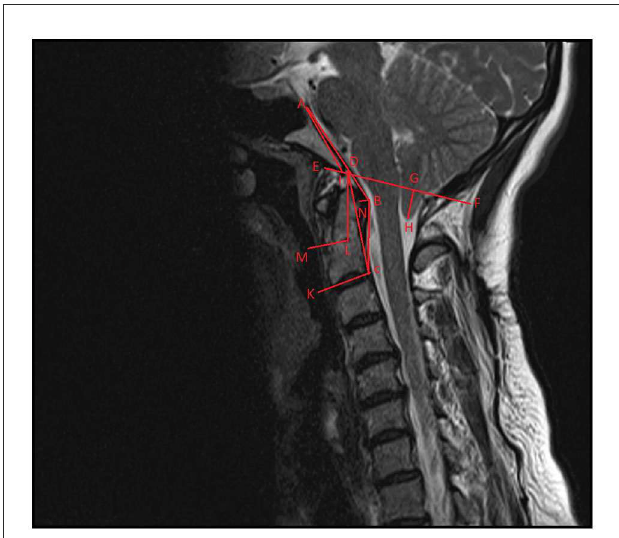
FIGURE1 Schematization of craniovertebral morphometric measurements on sagittal T-2-weighted imaging. ABC, modified clivoaxial angle; ADC, clivoaxial angle; GH, herniated cerebellar tonsil length; AD, clivus length; AIE, clivus angle; DCK, odontoid retroversion; DLM, odontoid retroflexion; DF, McRae